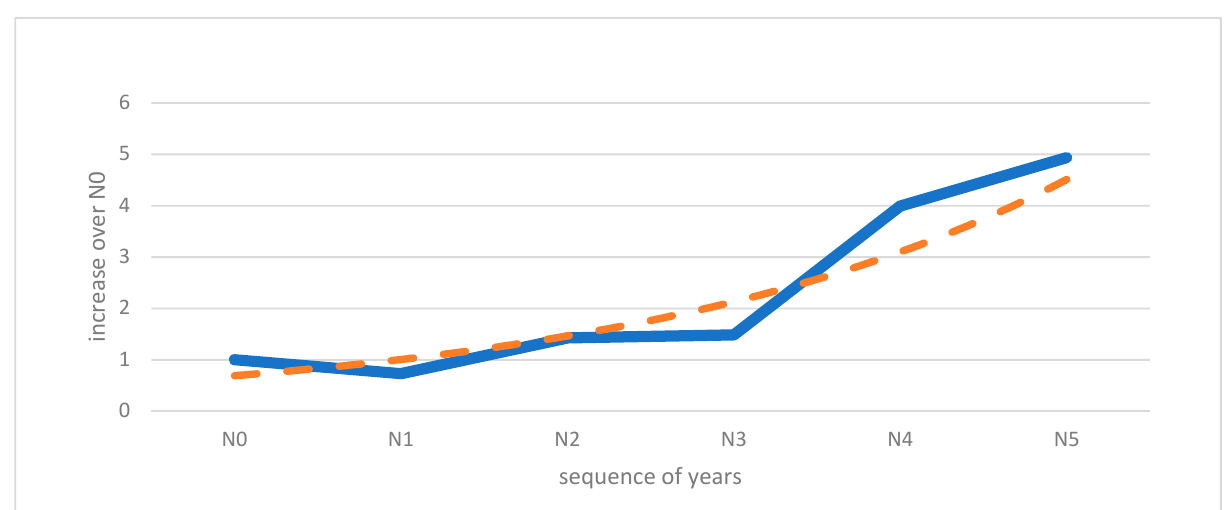
Figure 17. Ability to increase FC charging stations in Portugal, numerical evaluation (blue) and trend (orange).